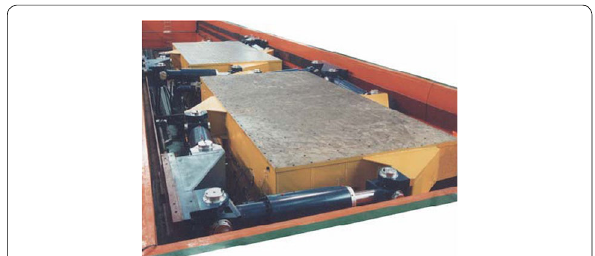
Figure 7 SERVOTEST seismic simulation system